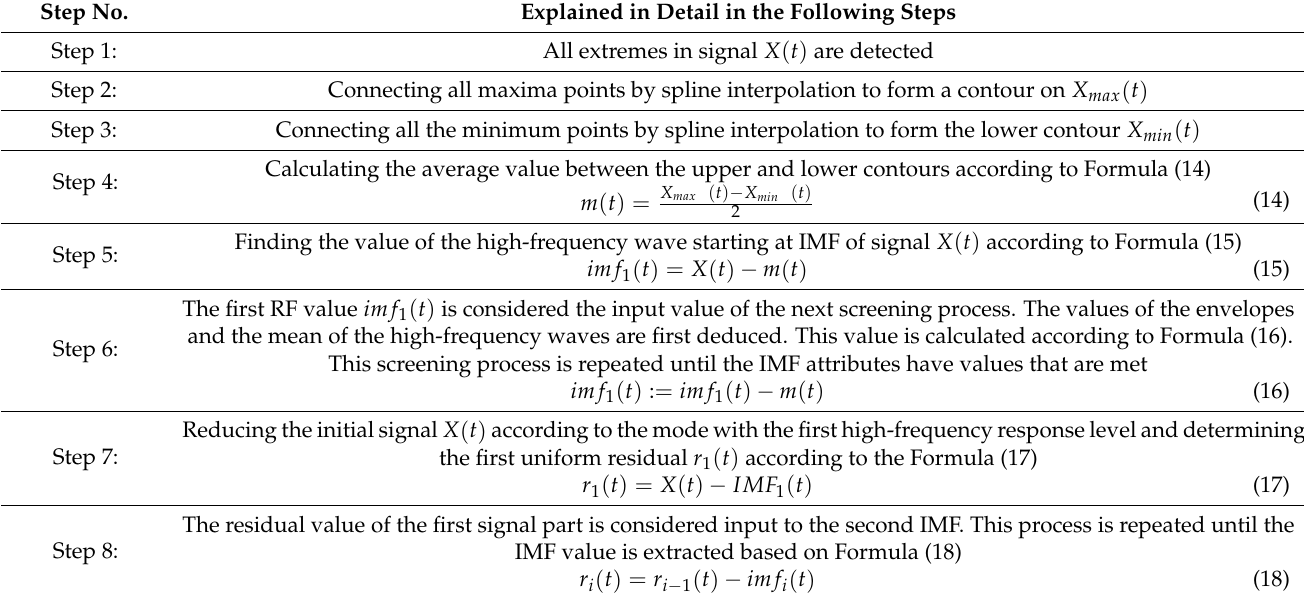
Table 5. The EMD